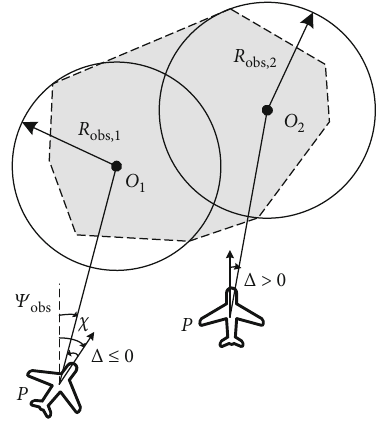
Figure 9: Avoidance direction